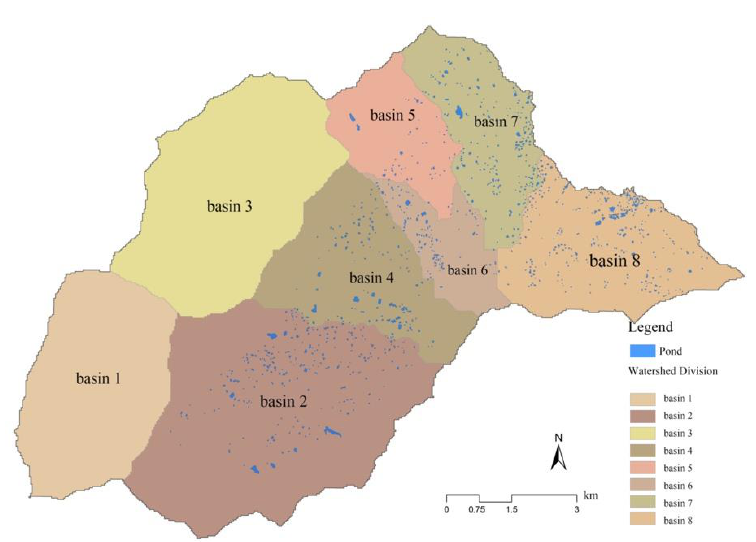
Figure 11. The watersheds result for the Shangzhuang Basin.